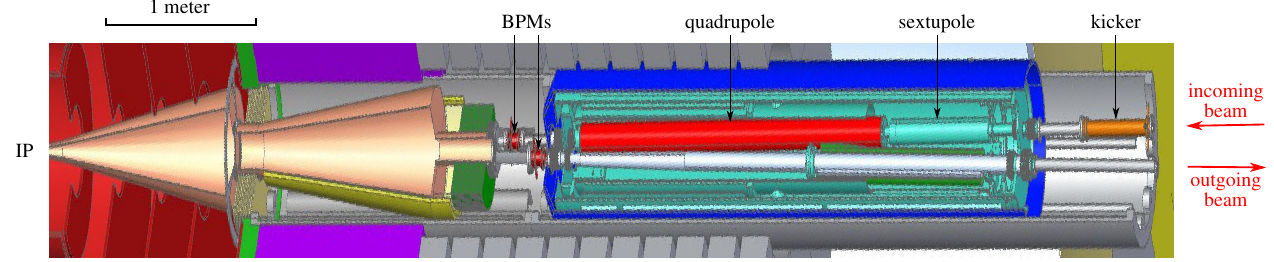
FIG. 4. Engineering schematic [14] of the IP region showing the location of the kicker on the incoming beam line and the feedback BPM on the outgoing beam line. A vertical-to-horizontal aspect ratio of 3 ∶ 1 has been used in this figure.